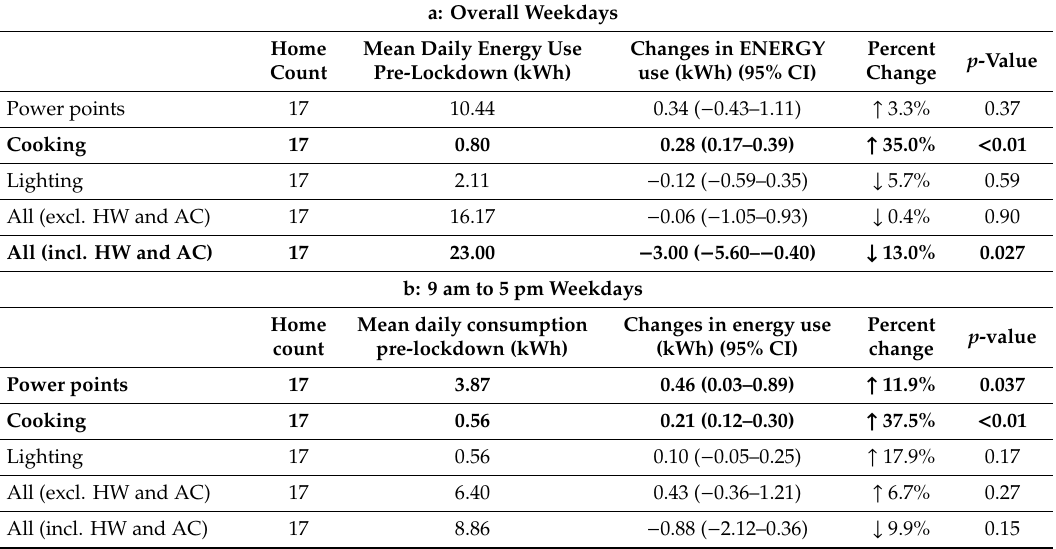
Table Notes : Bold = statistically significant ( p <